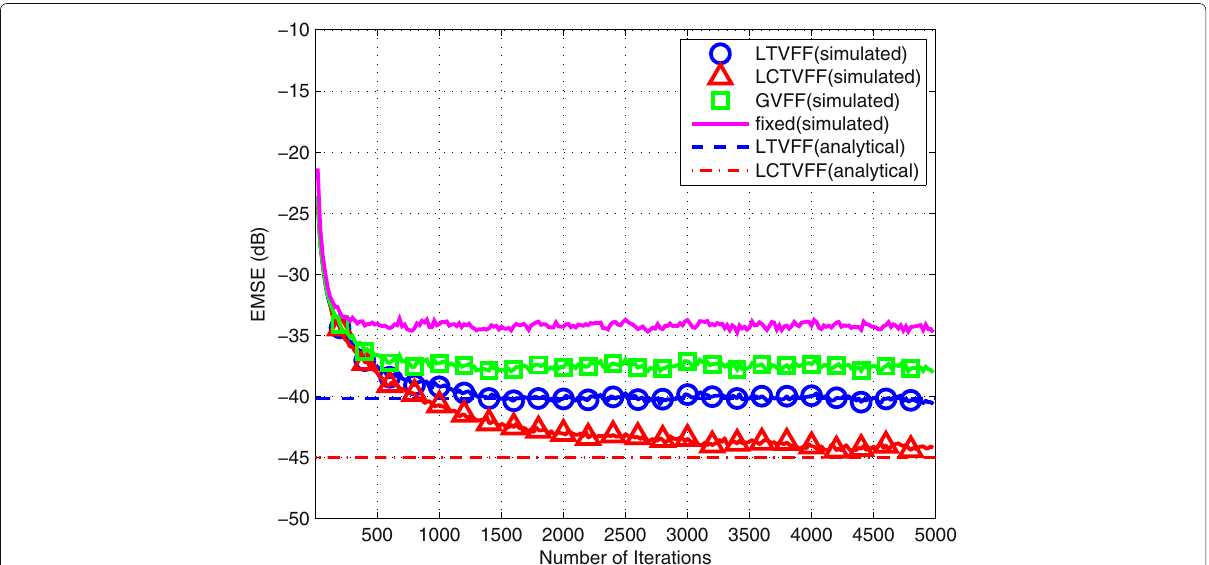
Fig. 11 EMSE curve against number of iterations for the proposed and existing algorithms